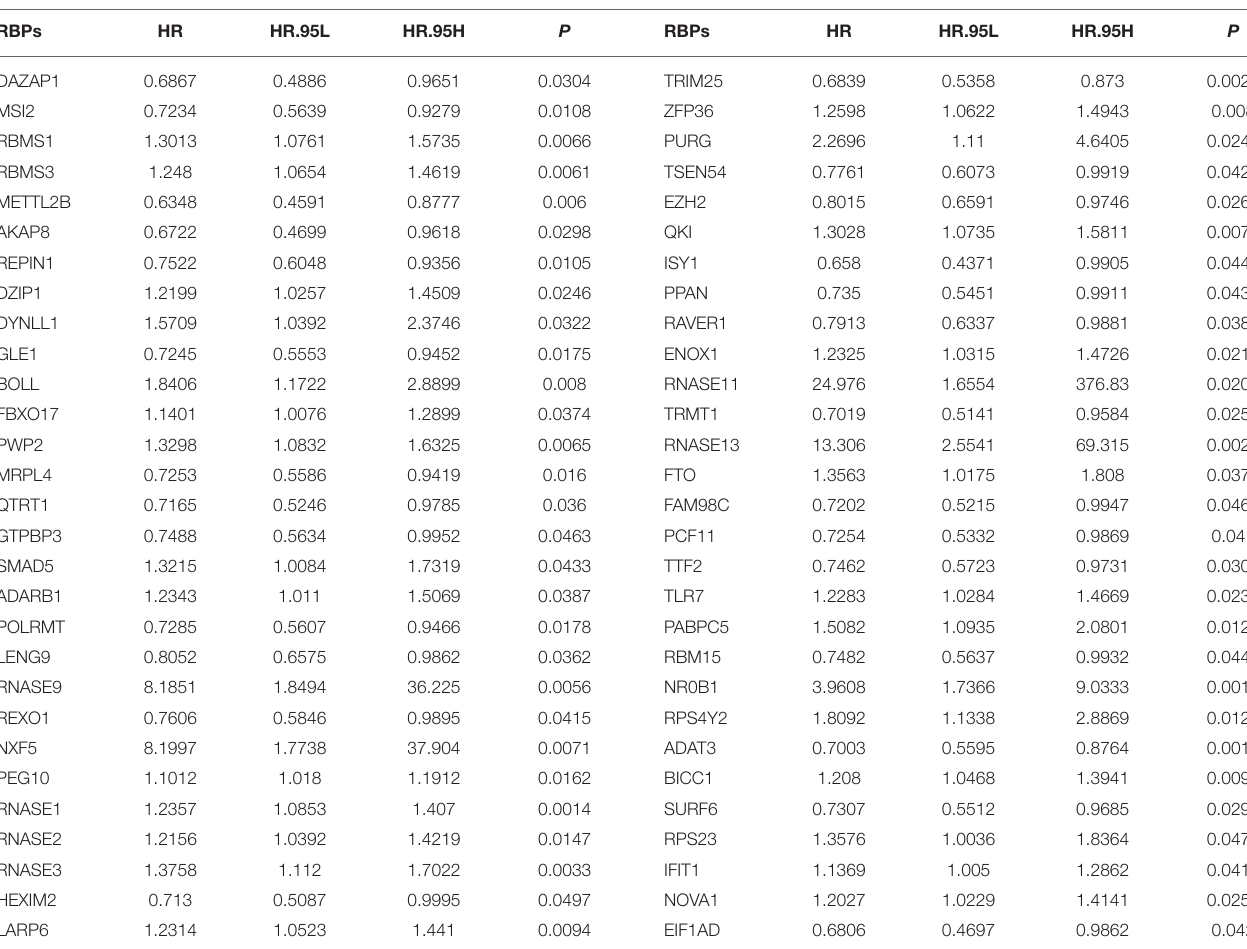
TABLE 1 | Univariate Cox regression analyses of survival-related RBPs in gastric cancer.